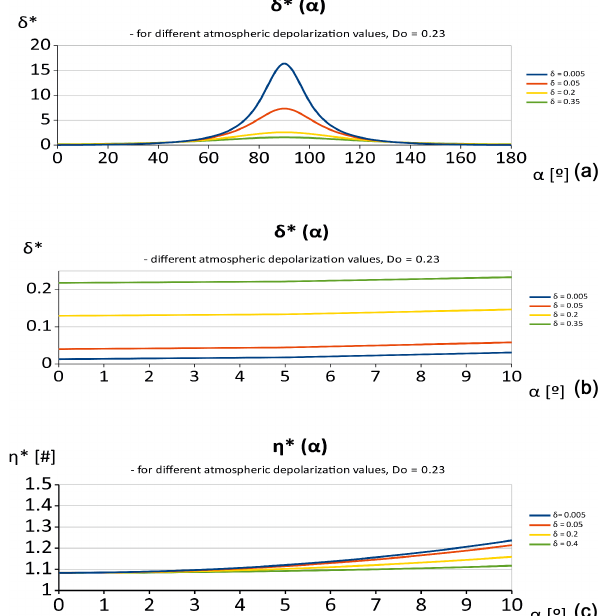
Figure 5. Numerical simulation: (a) Y – α simulations for several atmospheric depolarization values; (b) Y – α simulations for several diattenuation values; (c) Y – α simulations for several diattenuation values – zoomed